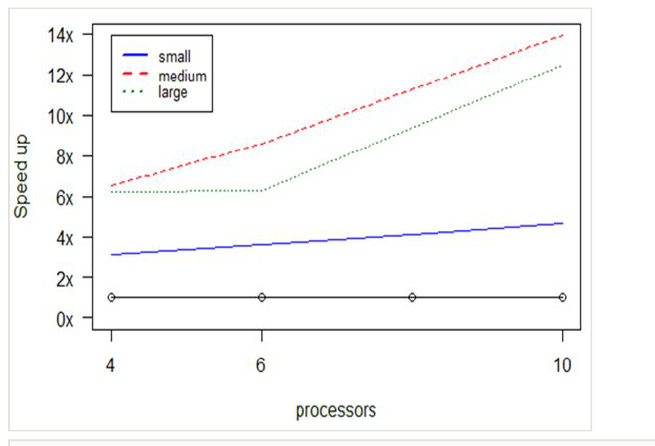
Computational results about optimization in taxa2dist+taxondive's performance, considering the number of processors (x-axis) and the size of the input